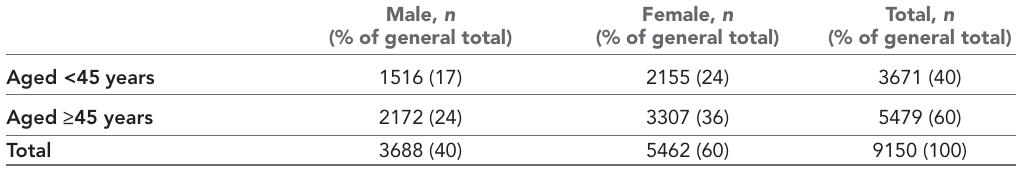
Table 2 General demographic characteristics of described patients